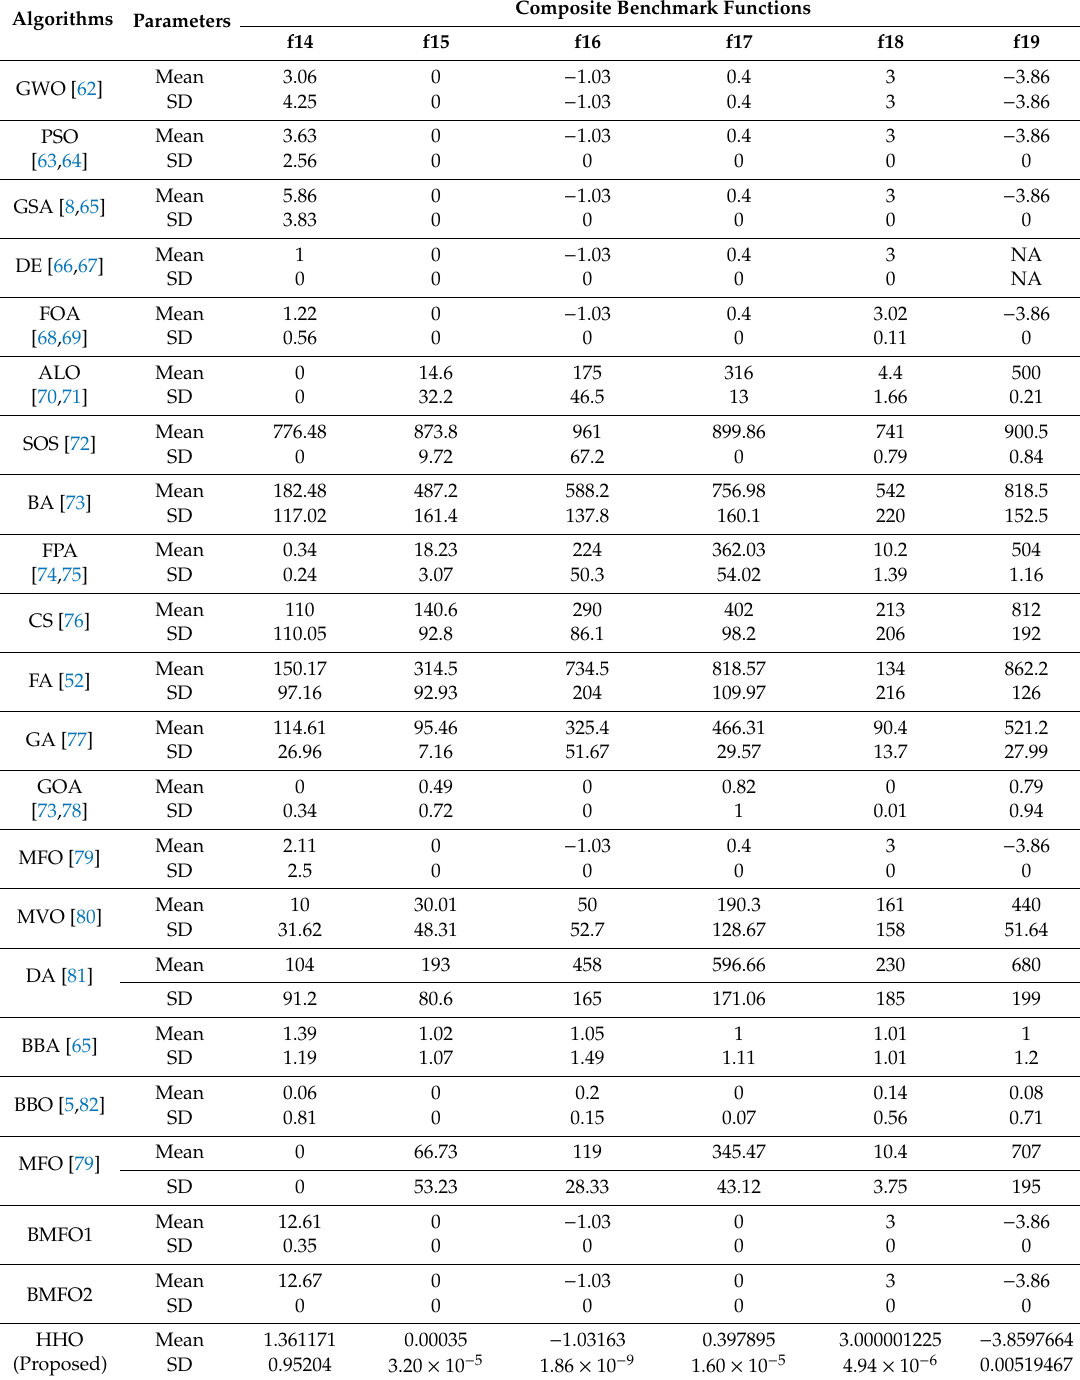
Table 9. Comparison of fixed dimension benchmark